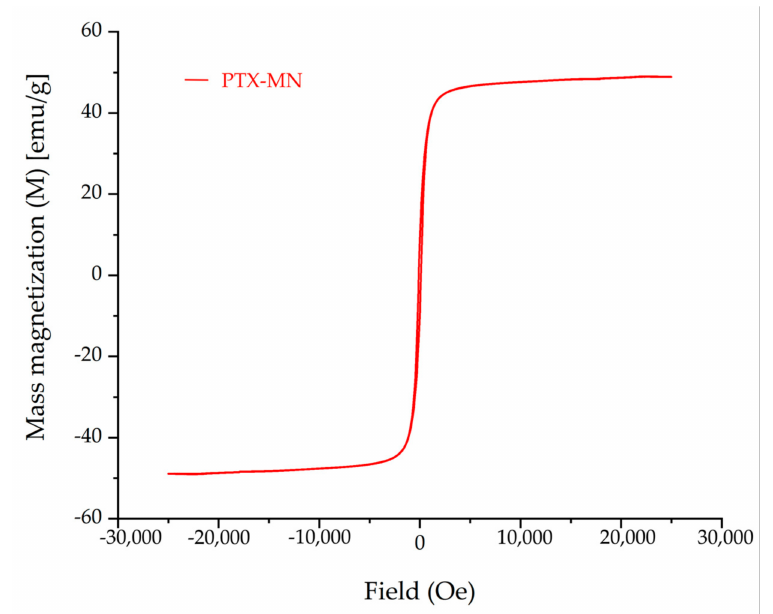
Figure 6. Magnetization curve of